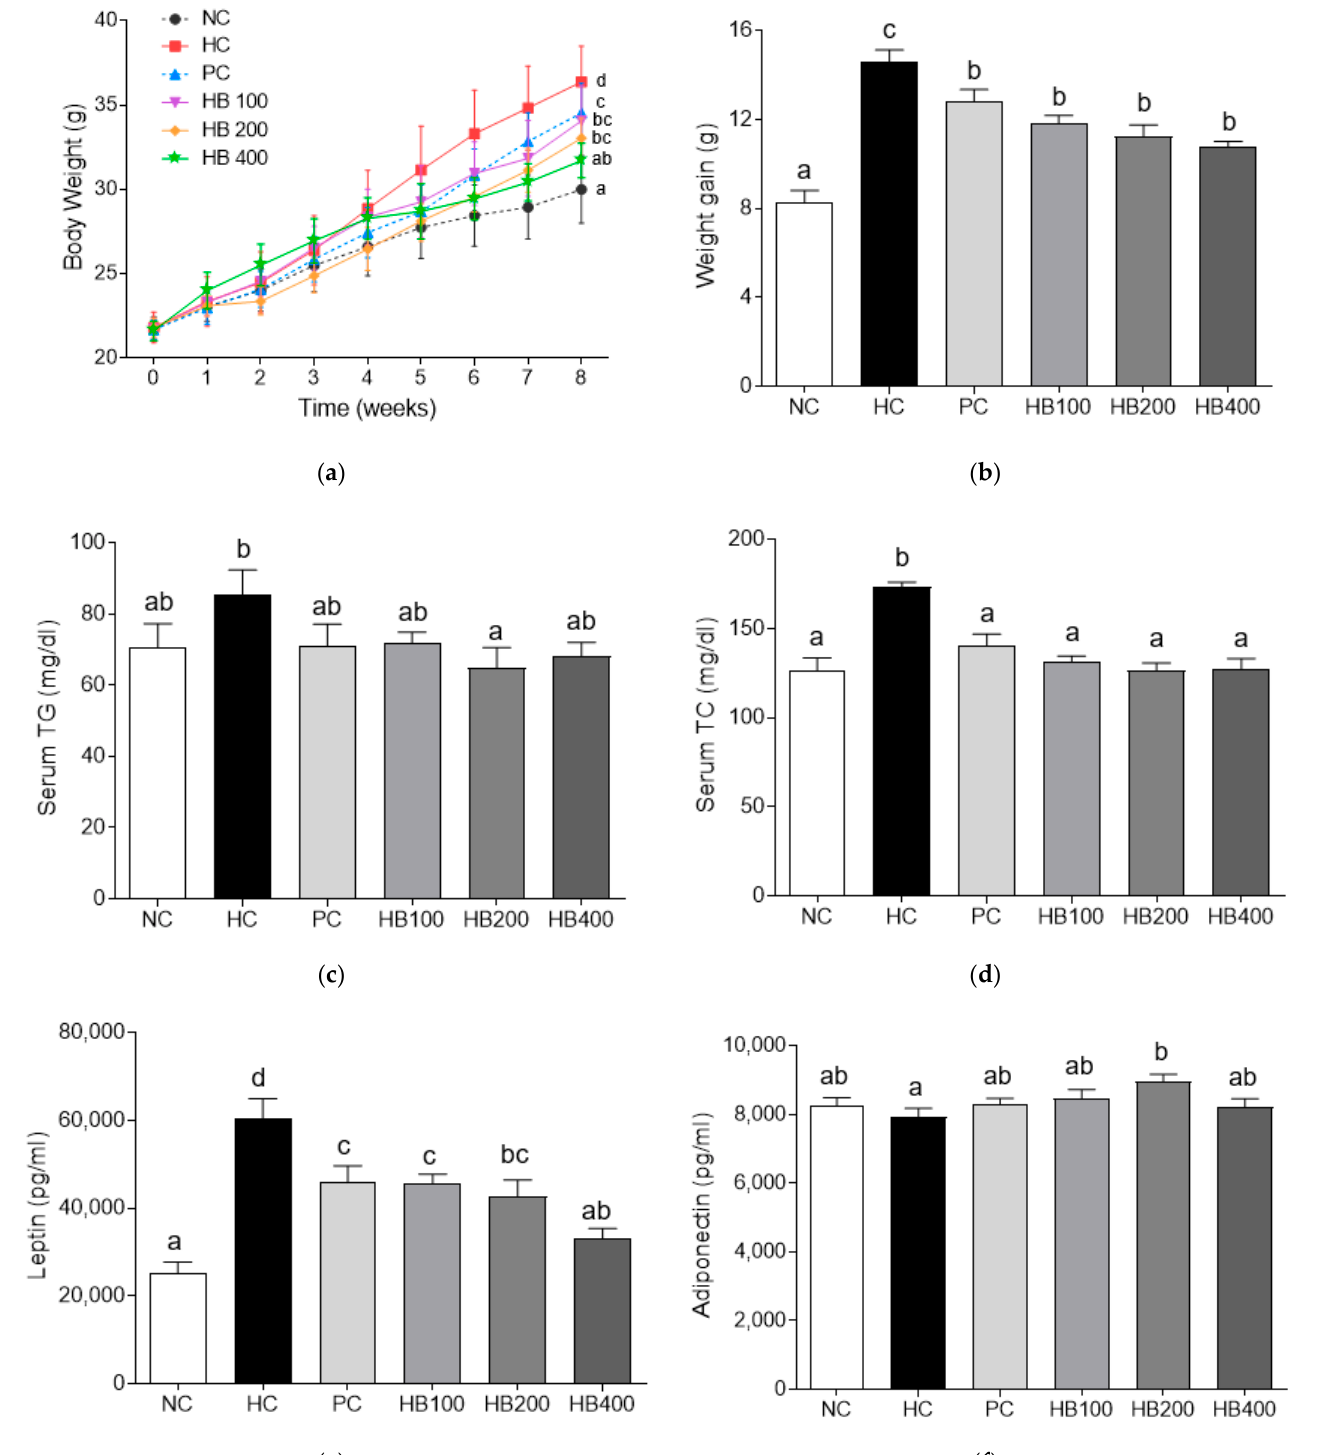
Figure 3. Effects of HB extract on body weight changes and serum biochemistry parameters. ( a ) Body weight; ( b ) weight gain; ( c ) serum TG; ( d ) serum TC; ( e ) leptin; and ( f ) adiponectin. NC, Normal diet Control; HC, HF diet control; PC, HF diet with orlistat 20 mg/kg; HB100, HF diet with honeysuckle berry extract at 100 mg/kg; HB200, HF diet with honeysuckle berry extract at 200 mg/kg; HB400, HF diet with honeysuckle berry extract at 400 mg/kg. Data are presented as mean ± SD ( n = 8). Different letters indicate significant differences by one-way ANOVA ( p < 0.05) followed by Duncan’s multiple range tests.